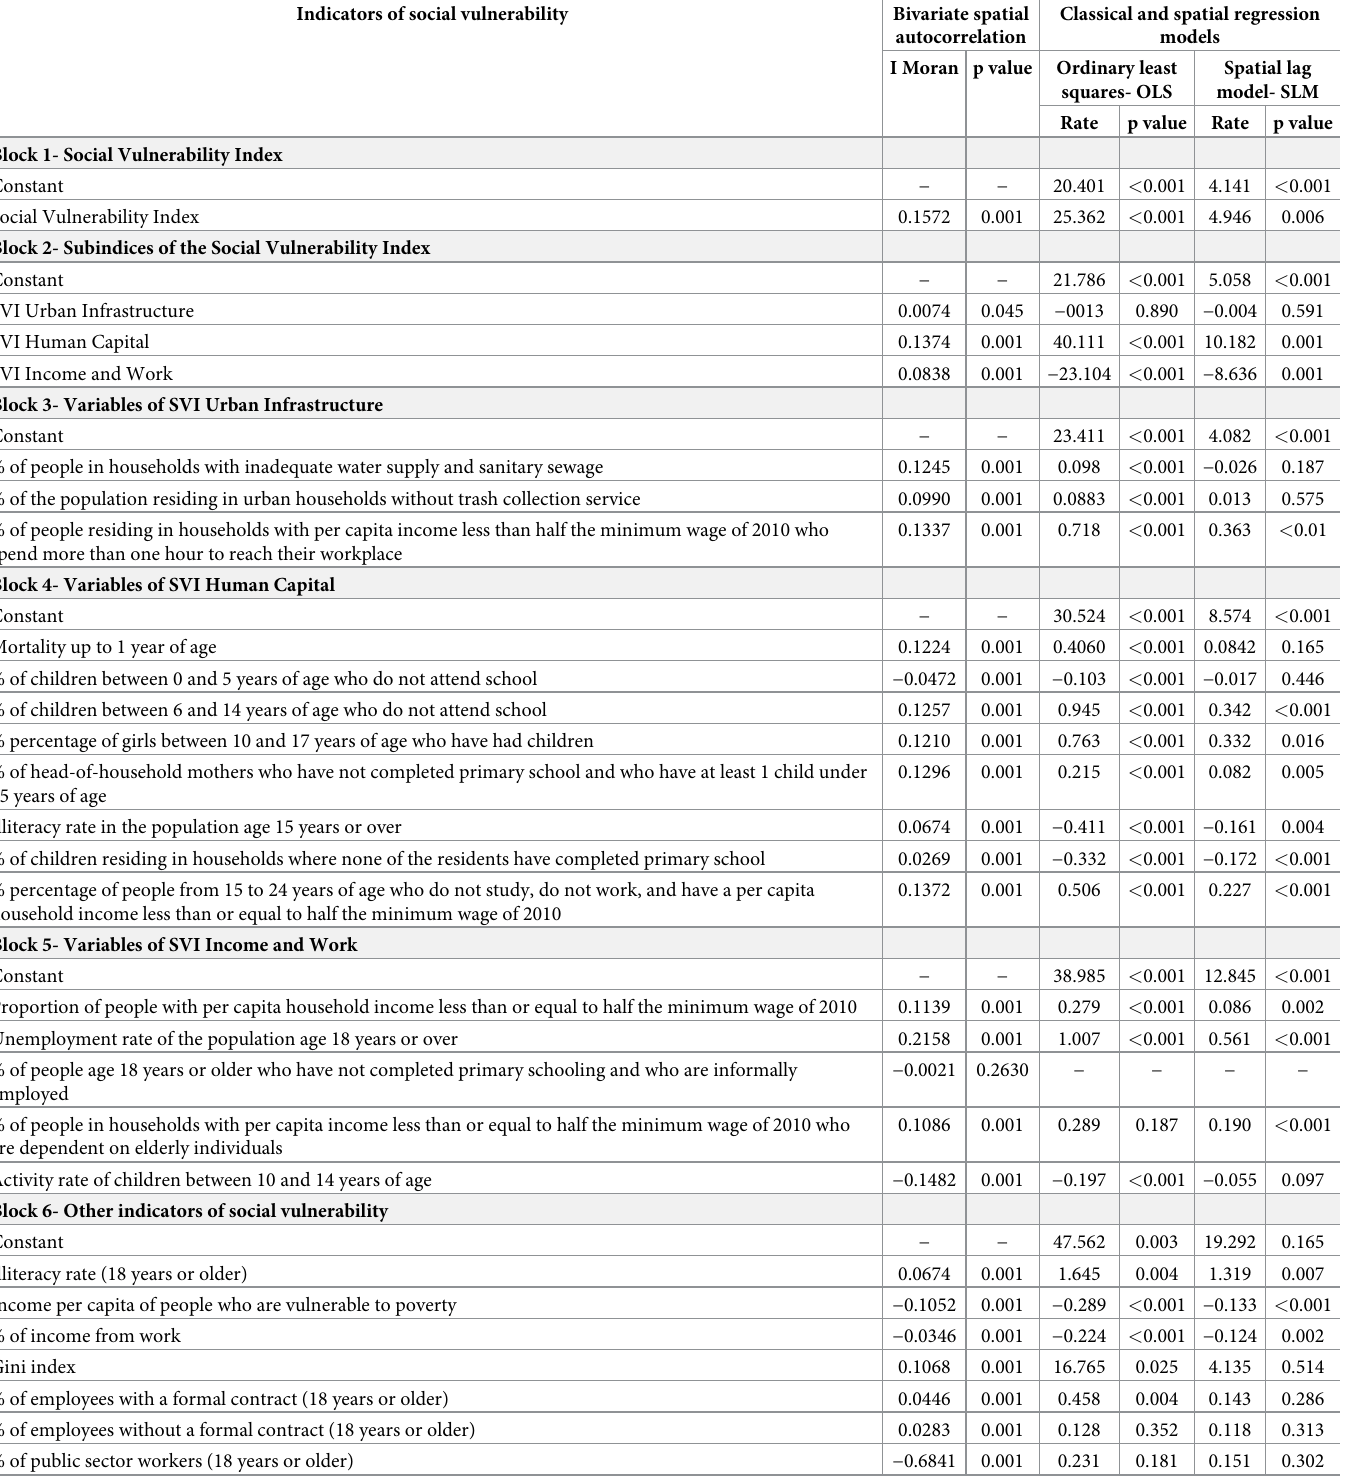
Table 3. Bivariate spatial autocorrelation and classical and spatial regression models of factors associated with the incidence rate of tuberculosis, corrected by the local empirical Bayesian model. Brazil,